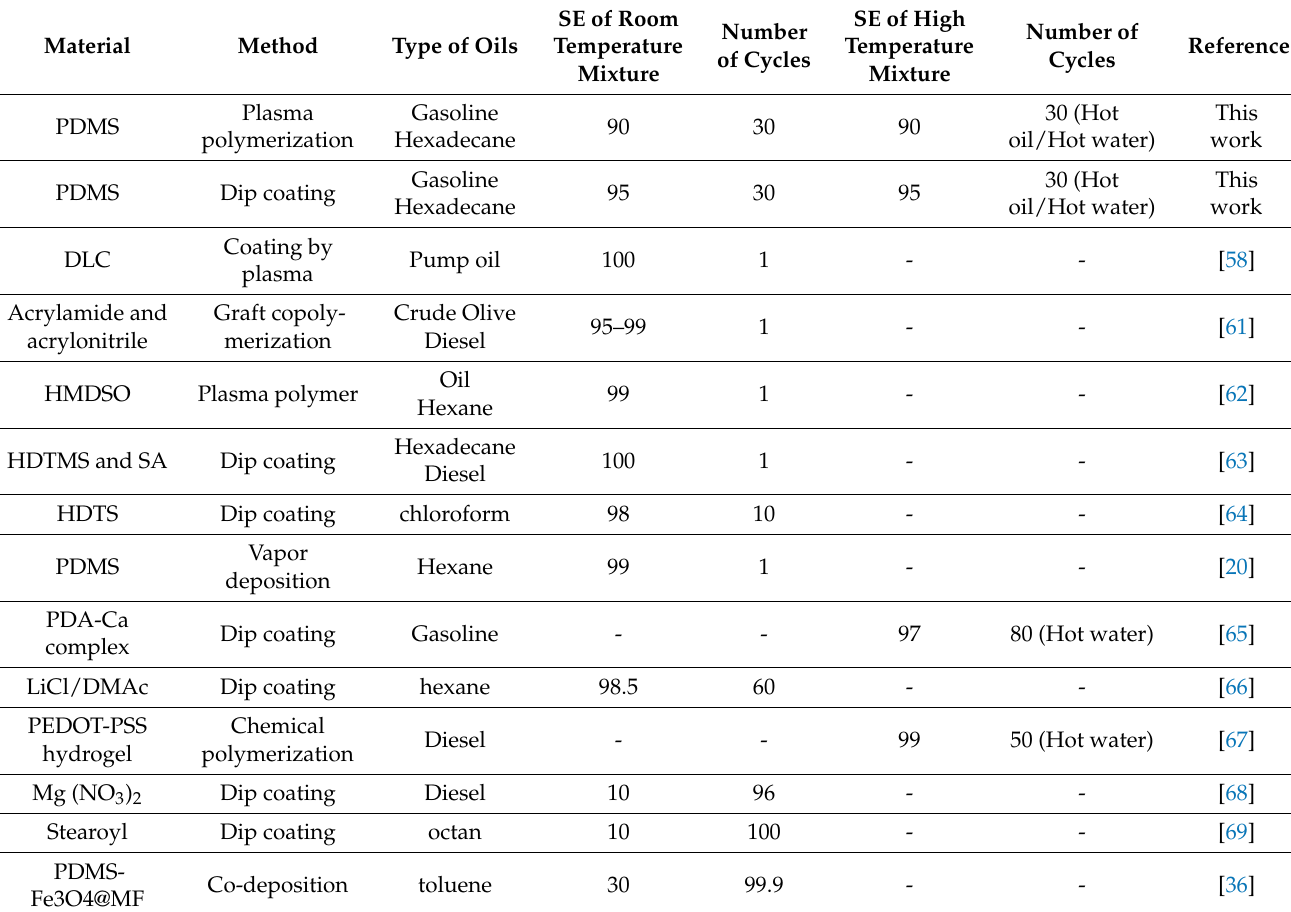
Table 2. Separation efficiency (SE) of different materials used as filters for hot oil/water